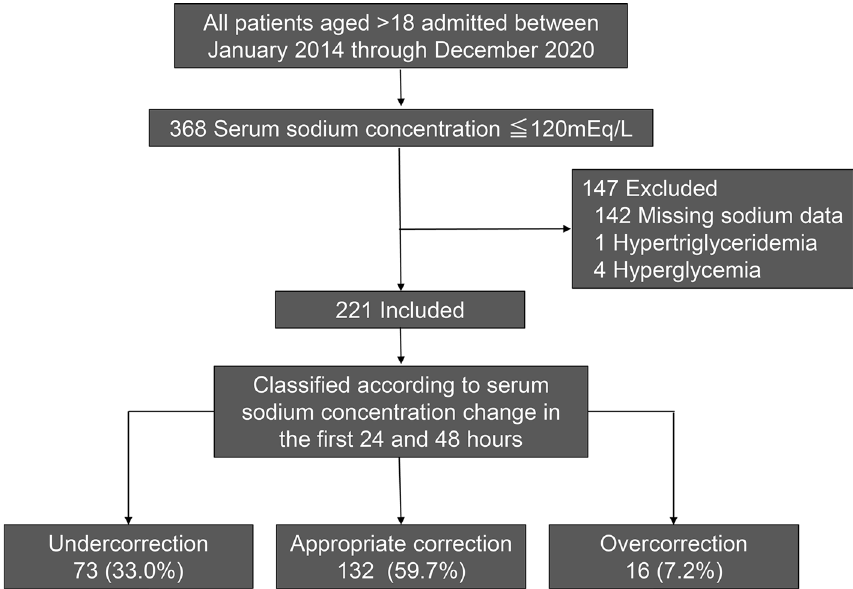
Figure 1. Patient selection process and subsequent categorization according to the degree of correction of